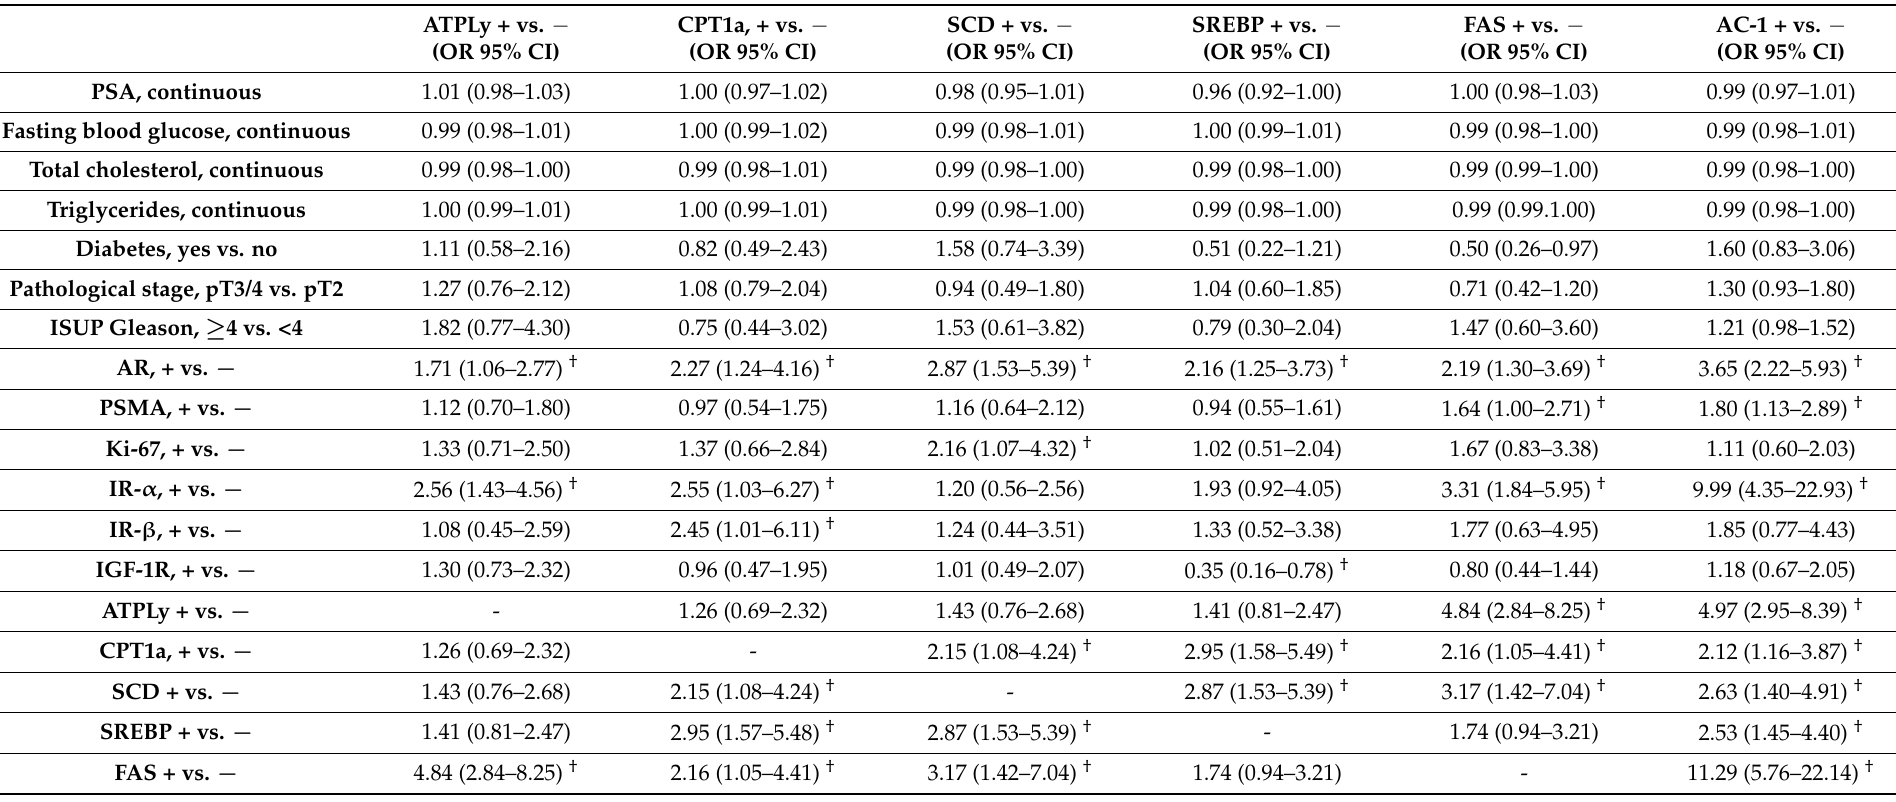
Table 3. Univariate logistic regression between immunohistochemistry results and clinical and pathological variables in PC patients. ATPLy + vs. − (OR 95% CI)